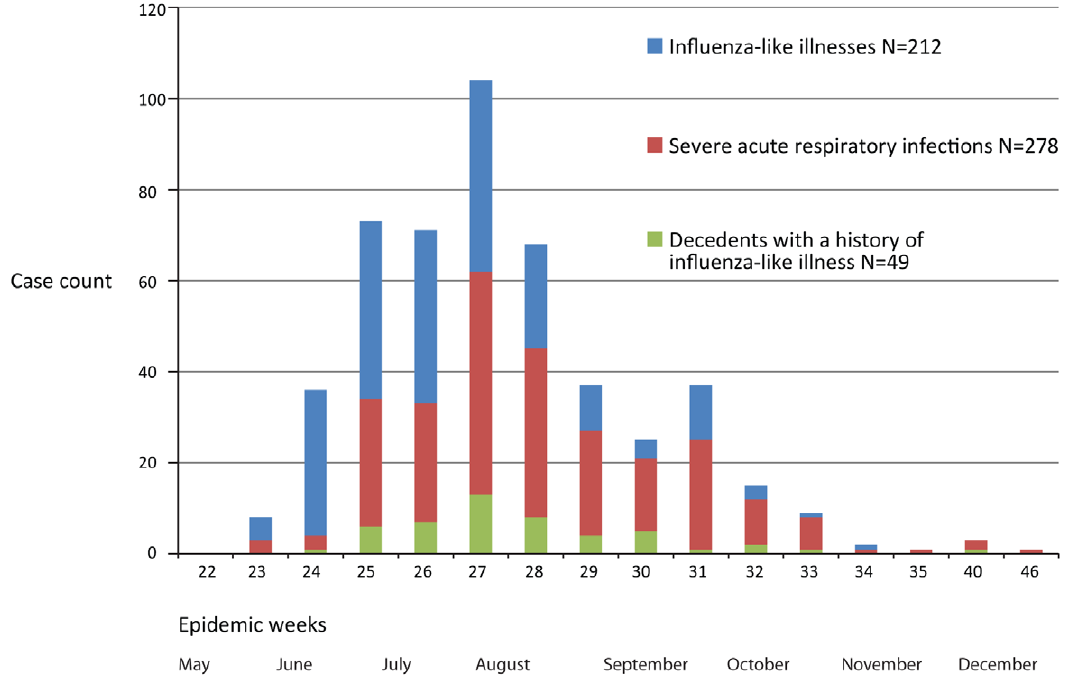
Figure 1. Distribution of influenza A(H1N1)pdm09-associated case-patients in three cities in Argentina by epidemiologic week, May–December 2009.